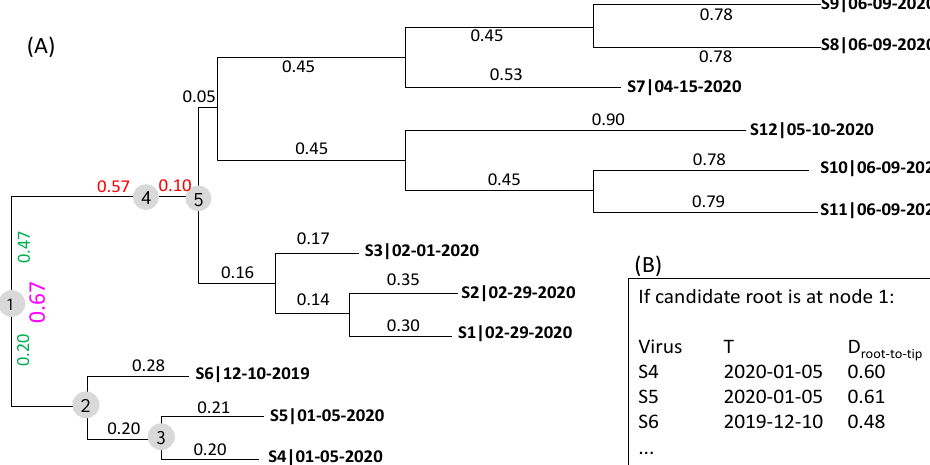
Figure 1. Conceptual illustration of the statistical framework for rooting the tree and dating the most recent common ancestor of the sampled genomes. ( A ) An unrooted viral tree with viral names in the format of Name|T where T is the collection date (mm-dd-year). Branch lengths are shown next to individual branches. Five internal nodes are numbered 1, 2, 3, 4, and 5, respectively. The branch length (0.67) between nodes 2 and 5 is bisected into the two green numbers by internal node 1, and into two red numbers by internal node 4. The root is unknown and could be anywhere along the branches. ( B ) The root-to-tip distance ( D ) when the root is placed at internal node 1.